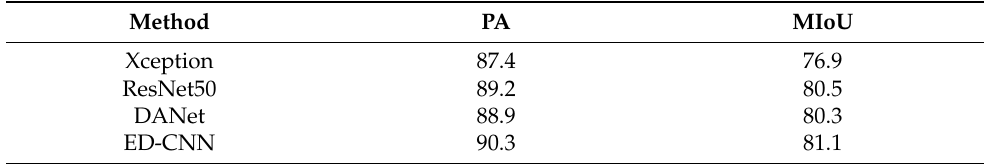
Table 2. Results of the three networks on dataset